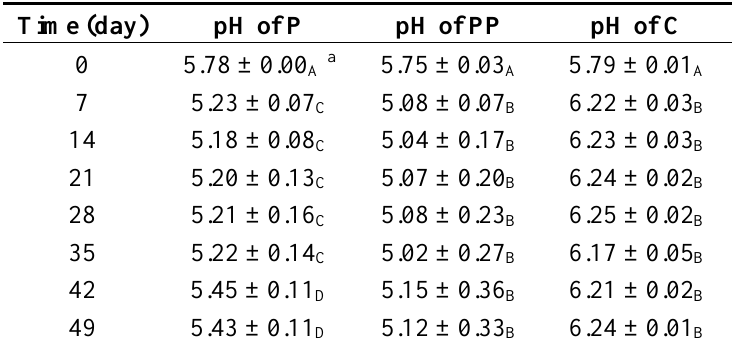
Table 2. The changes of average pH values ( n = 3) of oatmeal-coconut water matrix during refrigeration storage (4 °C).